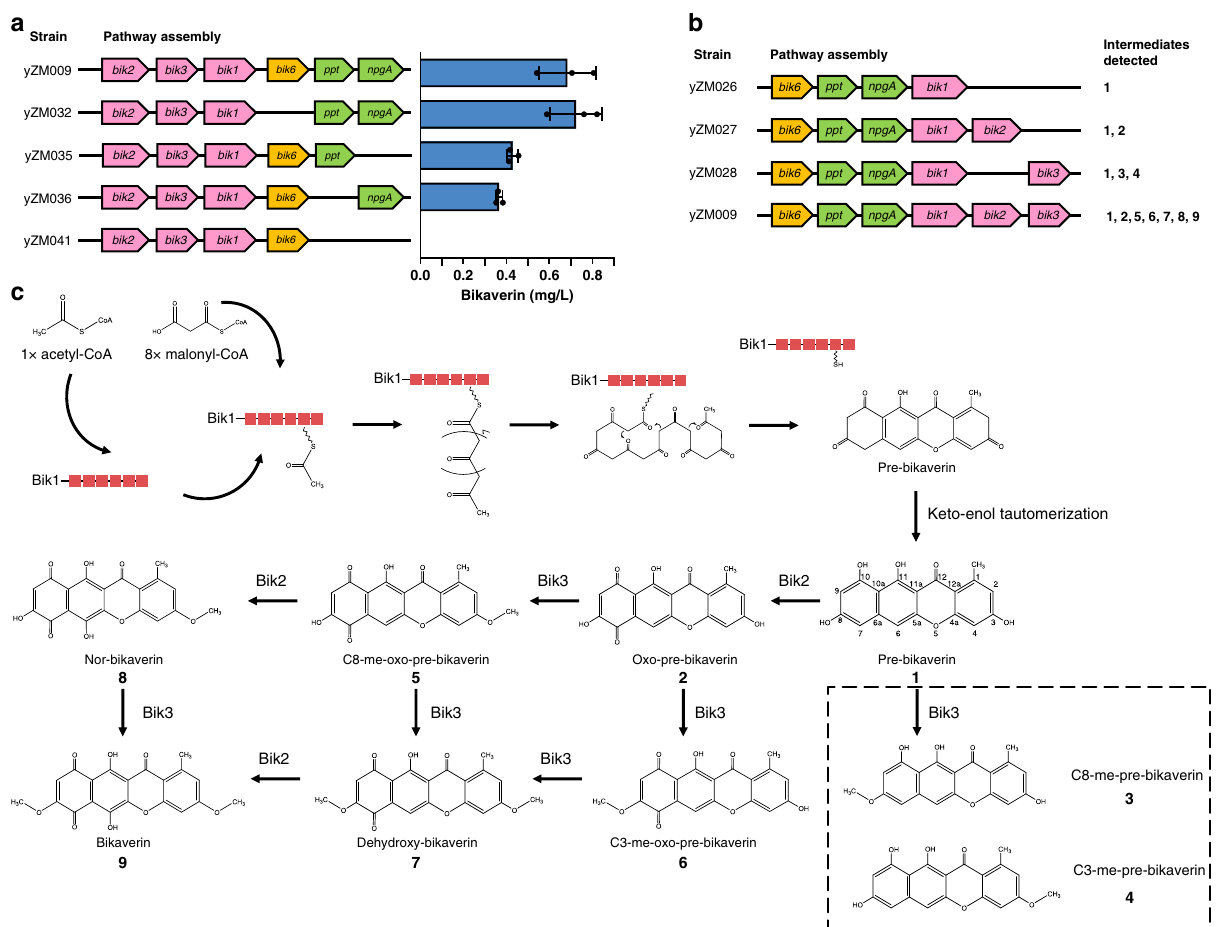
Fig. 4 Characterization of bikaverin synthesis in yeast. a A top-down strategy was used to measure the effects of bik6 , ppt1 , and/or npgA deletion on bikaverin production. Data are presented here as mean values ± SD calculated from n = 3 biological replicates. b As a bottom-up strategy, pathways containing different combinations of bik1 , bik2 , and bik3 were constructed. The intermediates ( 1 – 9 as in c ) was detected by HPLC – MS (Supplementary Figs. 5 – 8) and used to decipher the biosynthetic pathway of bikaverin. c The putative bikaverin biosynthesis pathway in S. cerevisiae . Multi-domain protein Bik1 is displayed as a series of connected red rectangles. Boxed intermediates were only detected in the absence of bik2 (Supplementary Fig. 6). Source data underlying a are provided as a Source Data fi